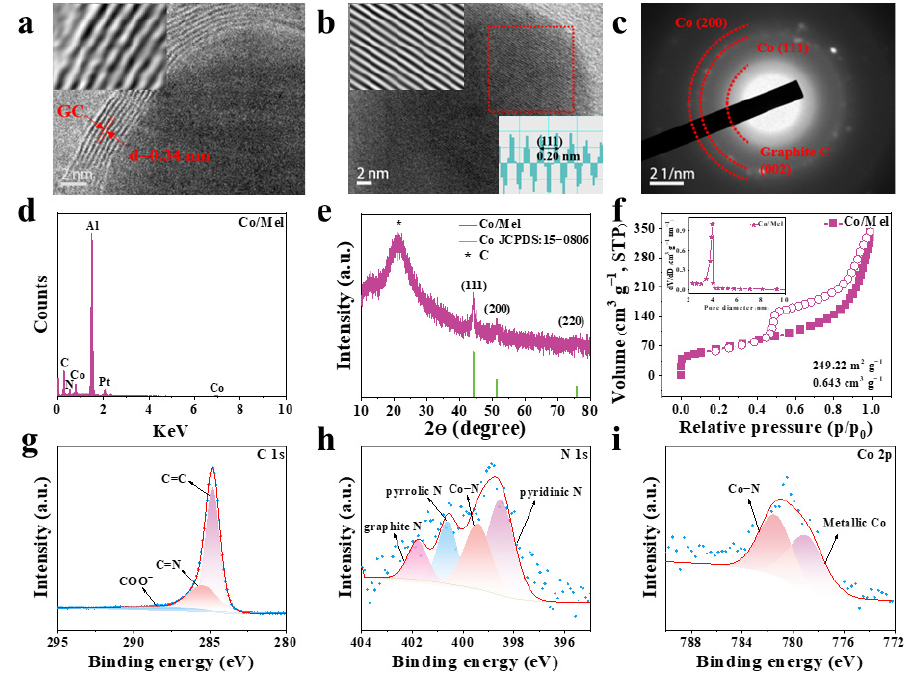
Figure 3. HRTEM images of Co/Mel ( a , b ); SAED image of Co/Mel ( c ); EDS spectra of Co/Mel ( d ); XRD pattern of Co/Mel ( e ); N 2 adsorption-desorption isotherm and pore size distribution curve of Co/Mel ( f ); XPS spectra of C 1s ( g ), N 1s ( h ) and Co 2p ( i ) of Co/Mel.